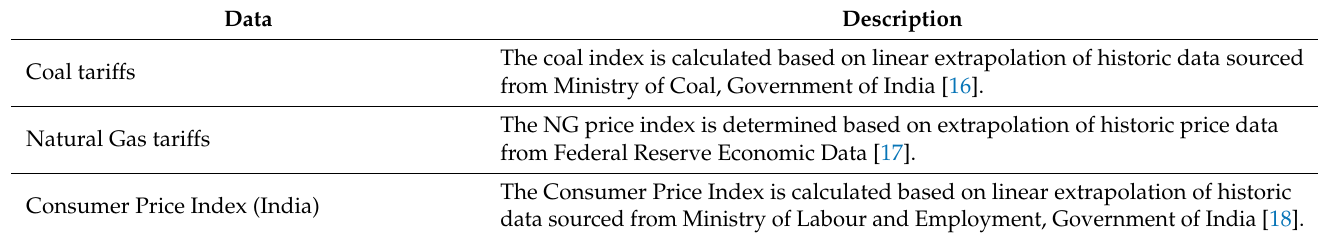
Table 2. Description of data used for experiments in this